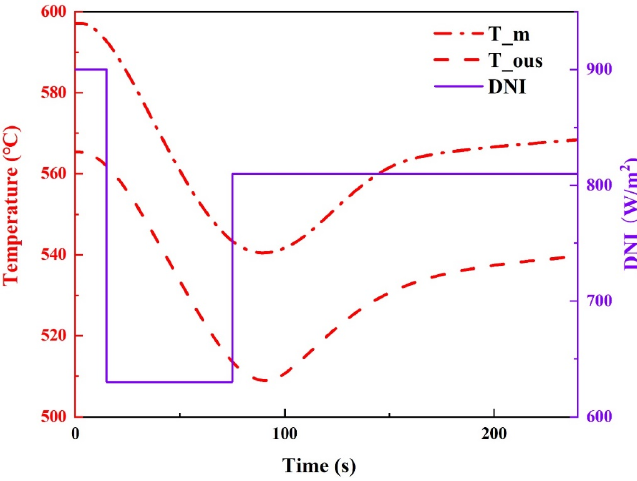
Figure 7. The results of the DNI disturbance.